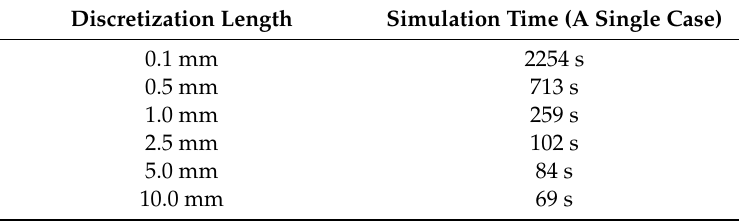
Figure 23. Comparison between cylinder curves with di ff erent discretization lengths (full load). Table 15. The simulation time of a single case with di ff erent discretization